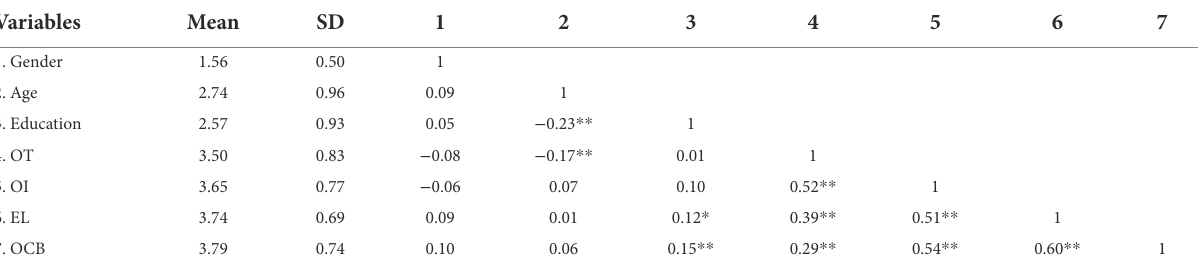
TABLE 3 Descriptive statistics and correlations among